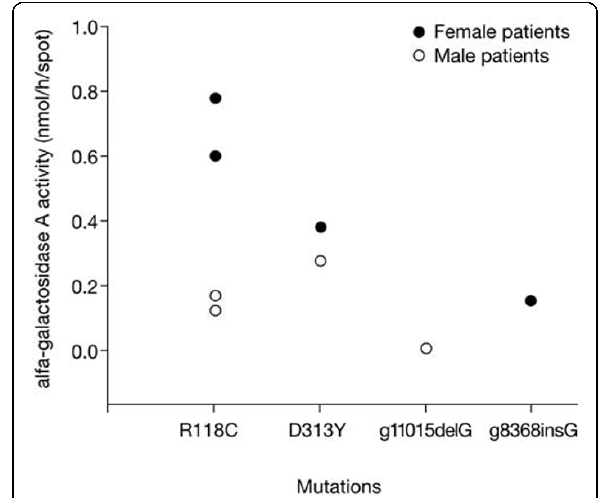
Figure 2 Activity of a -galactosidase A in patients with FD with different GLA mutations .